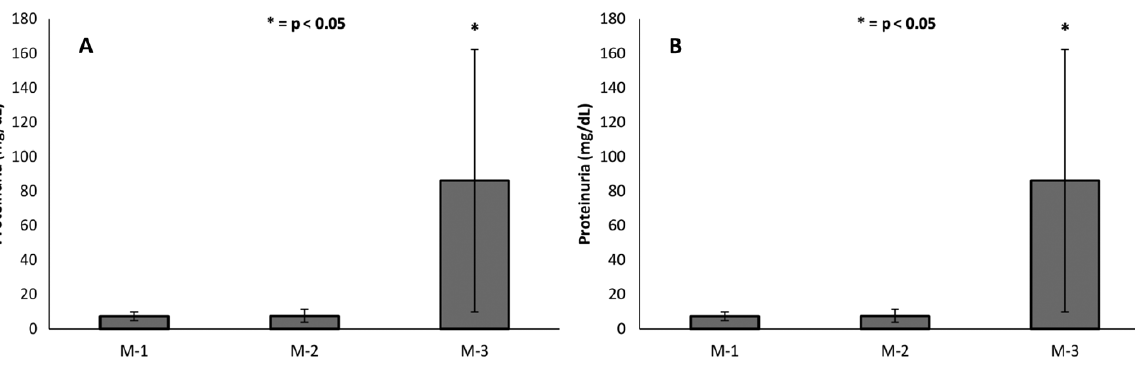
Figure 2 - Proteinuria in mg/dL (2A) and creatinine concentration in mg/dL (2B) at beginning of the training season (M-1), before (M-2) and after the competition (M-3). *= p < 0.05.